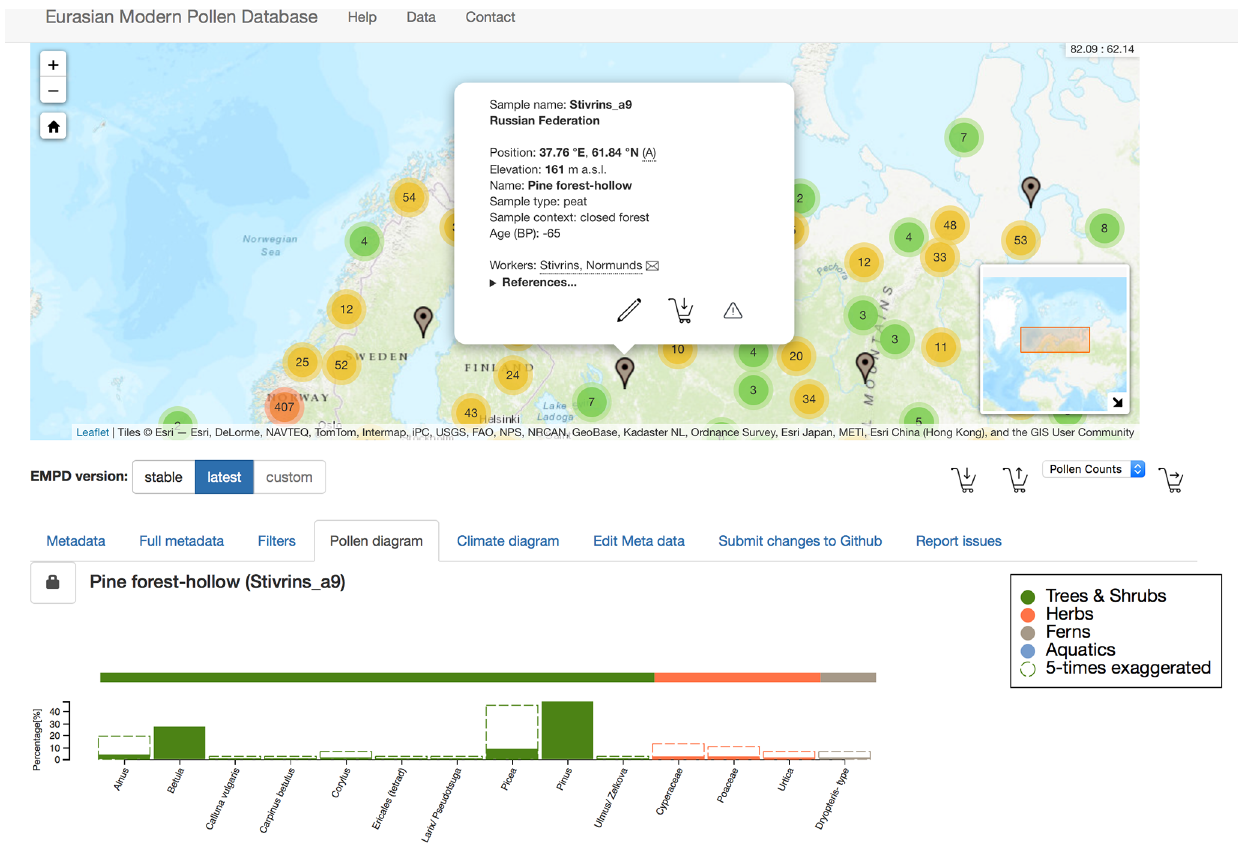
Figure 7. Screen grab of the EMPD online data viewer (available at https://empd2.github.io, last access: 20 January